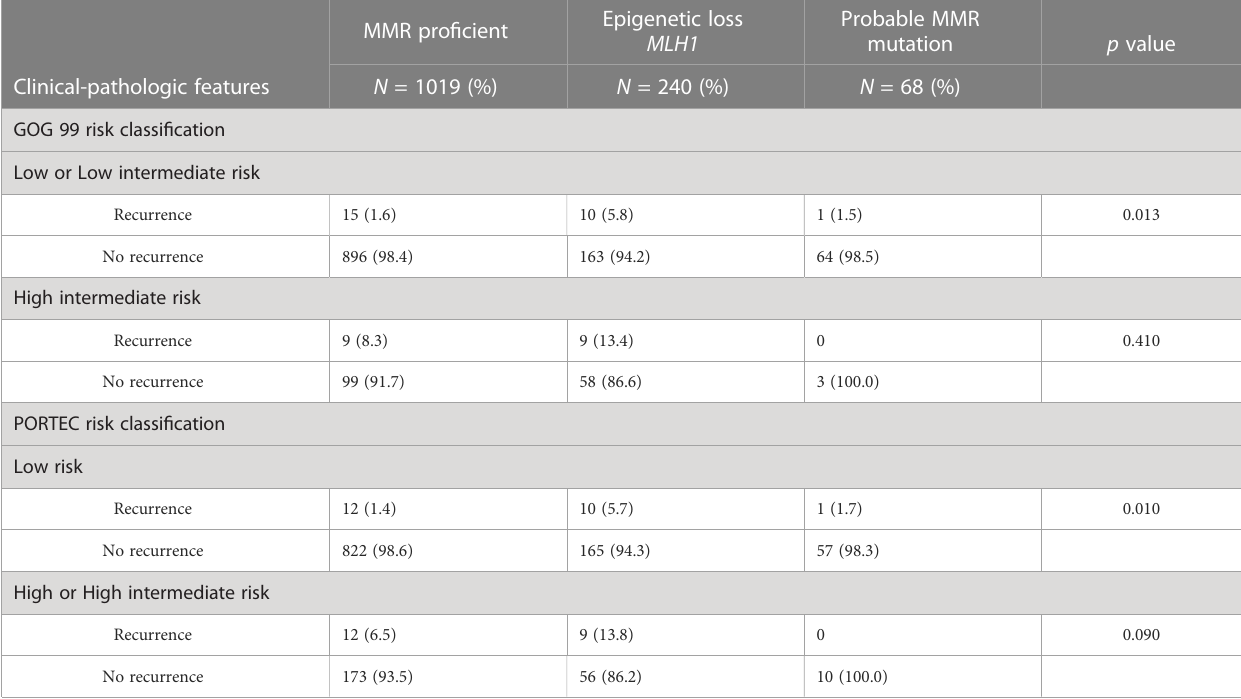
Clinical-pathologic